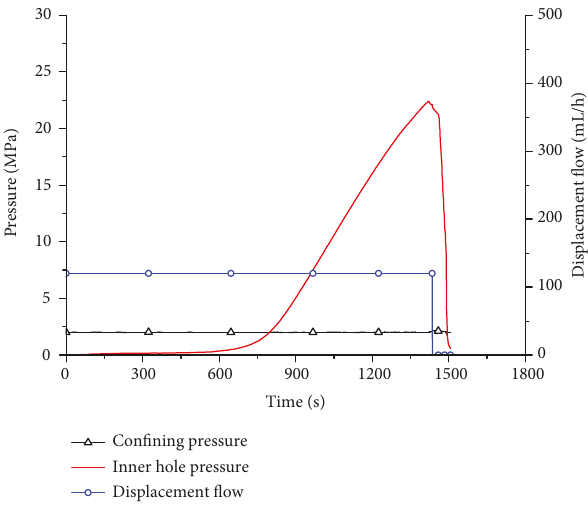
Figure 13: Pressure curves and displacement fl ow curve of the core fracturing